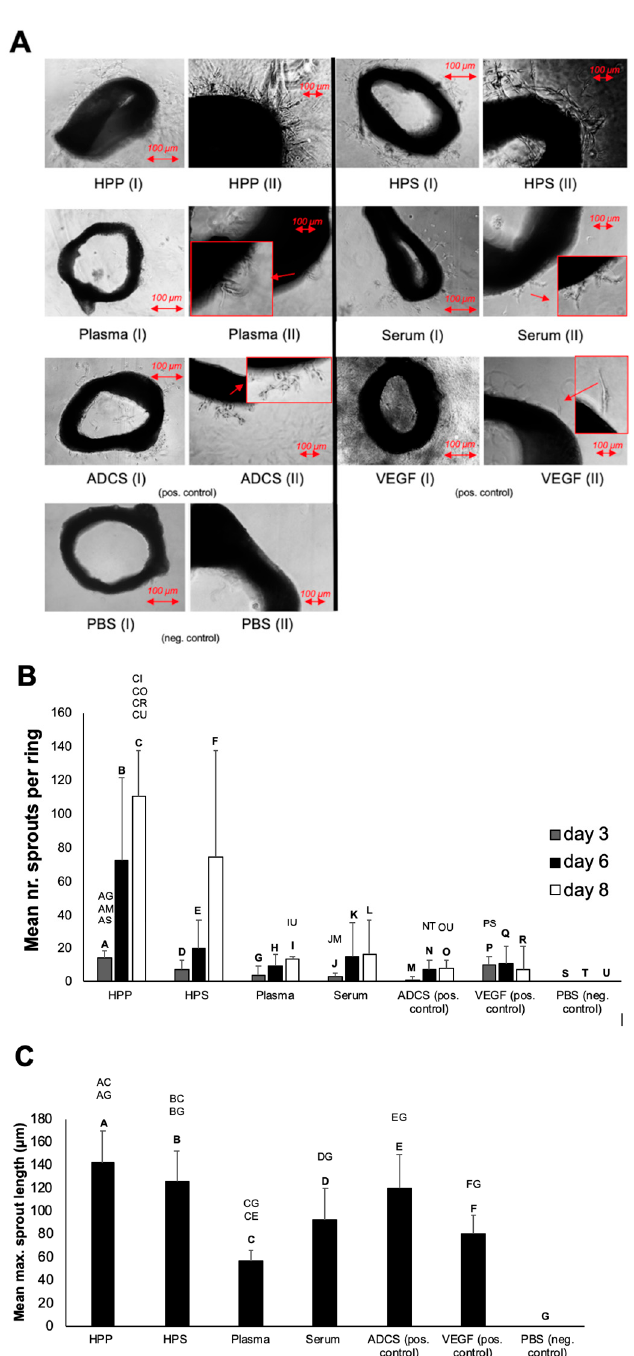
Figure 3. Effect of blood-derived secretomes on microvessel sprouting in the aortic ring assay. ( A ) Panel showing representative images of angiogenic sprouting assays (8 days culture), carried out in the presence of hypoxia preconditioned blood-derived secretomes (hypoxia preconditioned plasma (HPP) and serum (HPS)), normal plasma and serum, as well as positive controls (adipose-derived cell suspension (ADCS) and vascular endothelial growth factor (VEGF)) and negative control (phosphate buffered saline (PBS)) samples. Photographs were taken using a 10× (I) and a 20× (II) magnification. Enlarged image sections are indicated by red insets (Bars = 100 µm). ( B ) Plot showing the mean number of sprouts per ring over a culture duration of 3, 6 and 8 days ( n = 3). ( C ) Plot showing the mean maximum sprout length following a culture period of 8 days. Capital letter pairs over plots indicate statistical comparison of corresponding data points. For all pair comparisons, p < 0.05, unless otherwise indicated. Error bars represent s.d. ( n = 3).